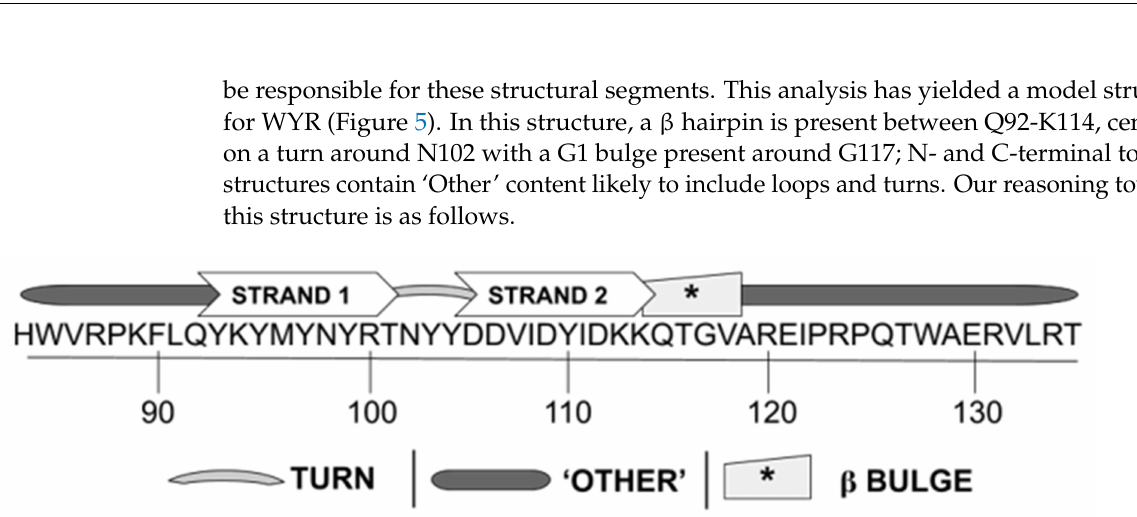
Figure 5. Pictograph model of WYR secondary structure elements. The numerical axis represents the #aa associated within the D. melanogaster flightin sequence. Strand 1 is the first strand of a 2-strand antiparallel β hairpin and is separated from Strand 2 by a turn segment proposed to exist between T101-Y104. C-terminal to Strand 2 is a β turn/G1 β bulge reliant on G117. Flanking the β and turn components is additional ‘Other’ content which may include loop and further turn